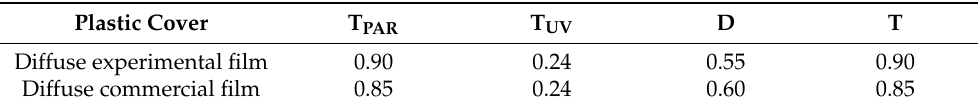
Table 2. Optical properties of plastic cover films. T PAR , transmission of photosynthetically active radiation [400–700 nm]; T UV , transmission of ultraviolet light [300–380 nm]; D, diffusion of light;